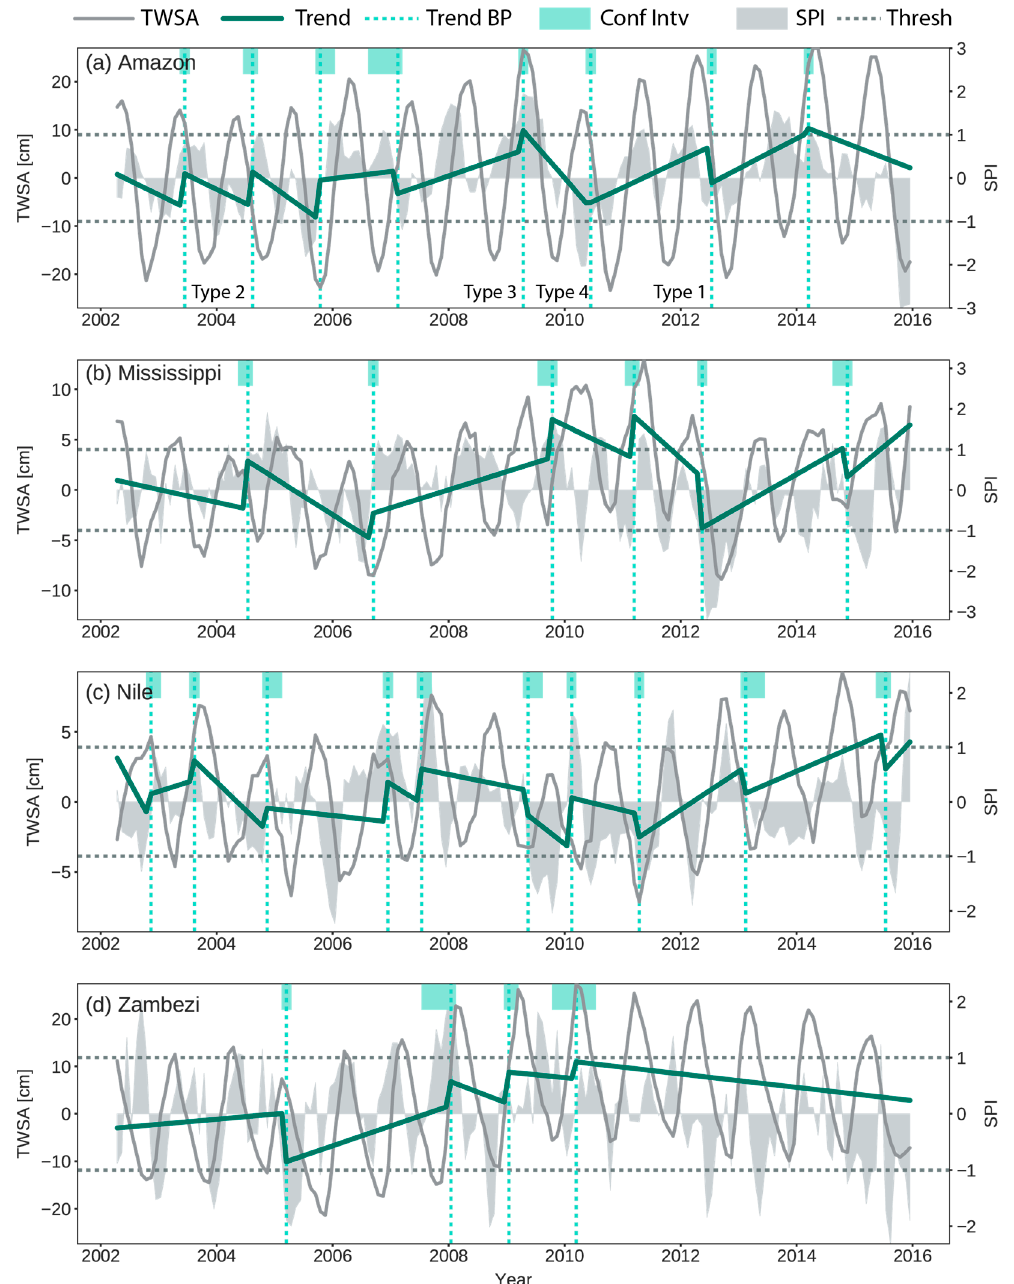
Figure 4. BPs detected over ( a ) Amazon, ( b ) Mississippi, ( c ) Nile, and ( d ) Zambezi river basins. Left axis: CSR-M TWSA (dark gray line), BFAST trends (solid green line), breakpoints (vertical dotted line), confidence intervals (light green shades); right axis: SPI (filled gray areas) and ±1 SPI thresholds (horizontal dotted lines).